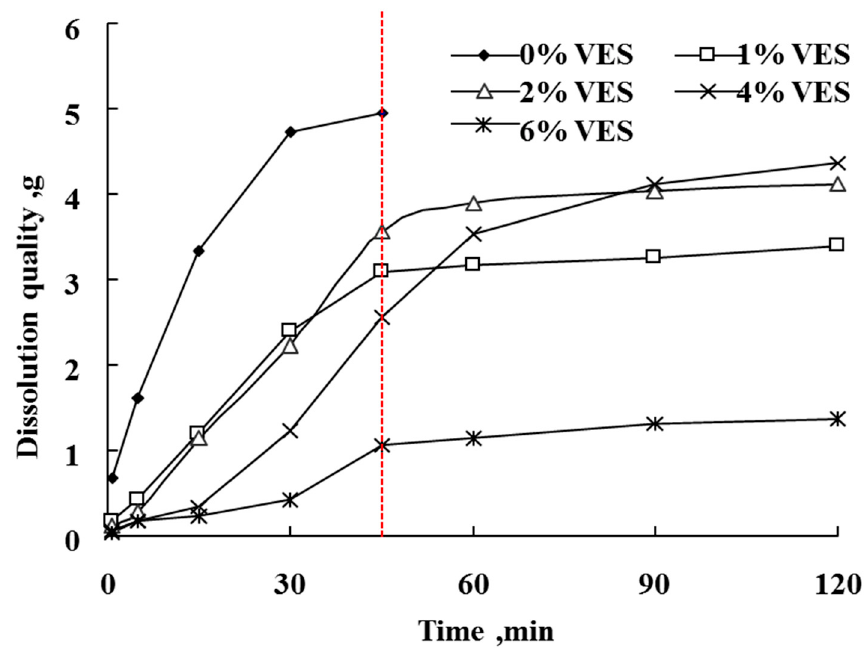
Figure 4. Effect of VES concentration on the dissolution quality.